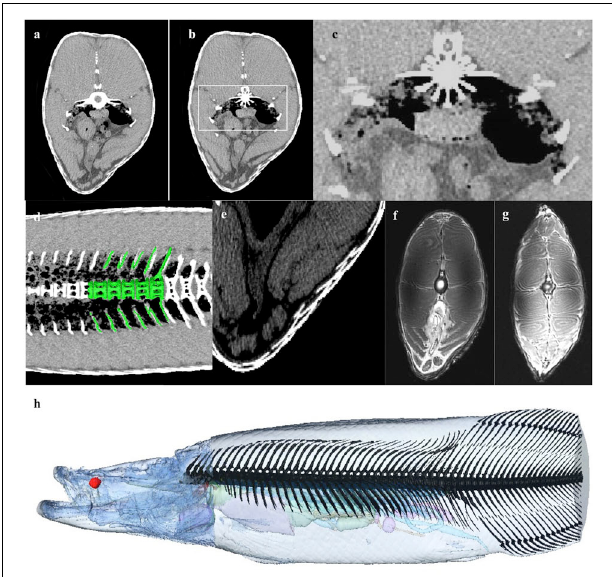
FIGURE 10 | Musculoskeletal and Integument. (a) Axial CT at level of GB demonstrating air partially encased between the bony cortices of the transvers processes of the vertebral bodies, and (b,c) shows spiculation of the vertebral body, possibly to increase surface area of respiratory epithelium exposed to air. (d) 3D rendering of vertebrae on background of coronal CT slice showing air density within part of the in the vertebral body between spicules. (e) Axial CT section demonstrating flexible dermal armor of elasmoid scales made from overlapping layers of type 1 collagen and a highly mineralized hydroxyapatite outer layer (Yang et al., 2014). Scales overlap with a thickness up to 9.7 mm. Single scale thickness is approximately 3.4 mm. (f,g) The muscle is divided in to left and right epaxial and hypaxial muscle by the vertical and horizontal septa. (h) Bony axial skeleton reconstructed from CT data (excluding distal